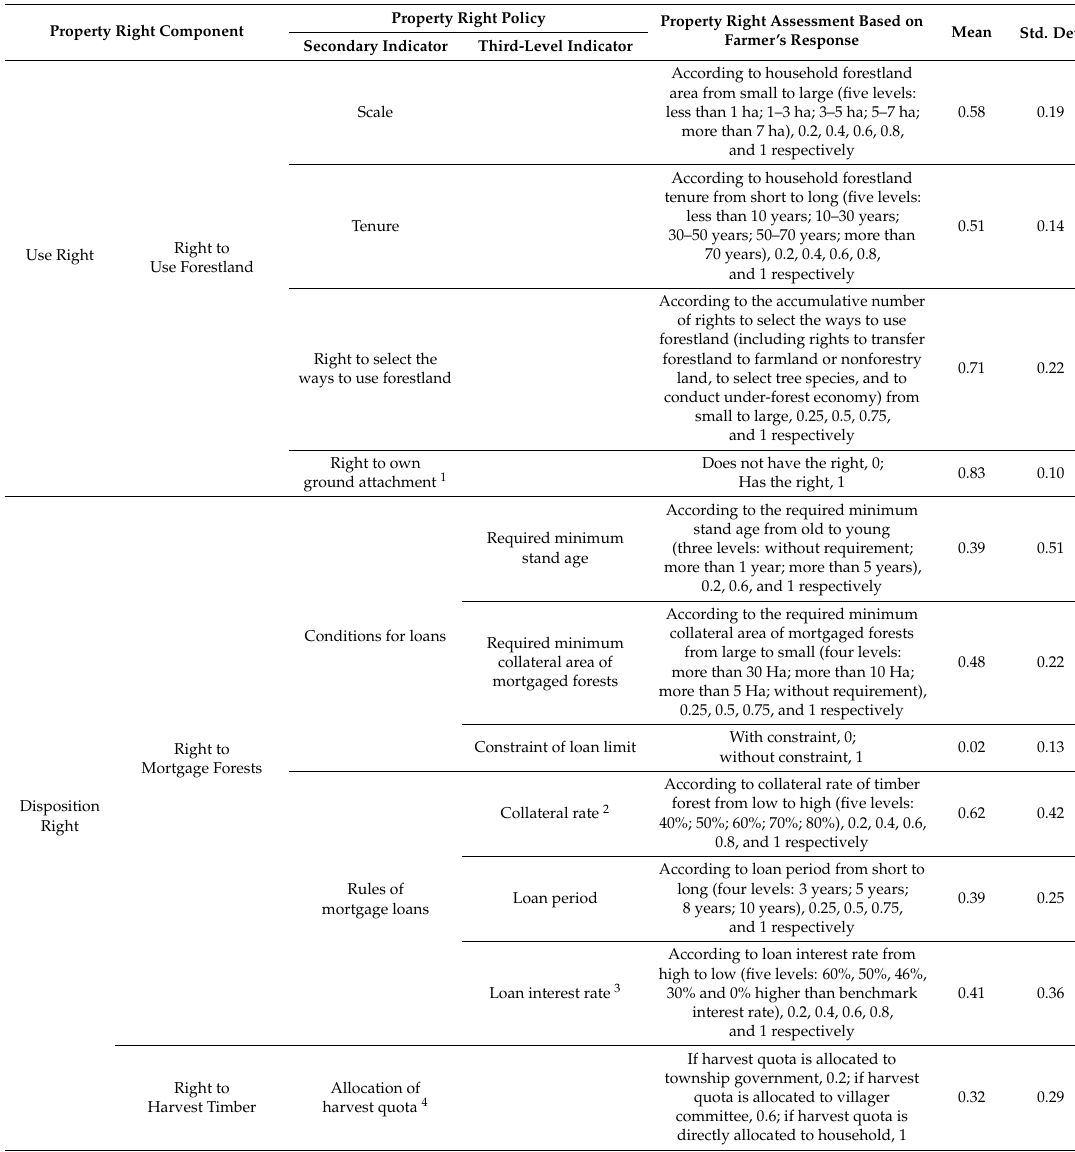
Table A1. Operationalization of variables in the measurement of forest property rights and its descriptive